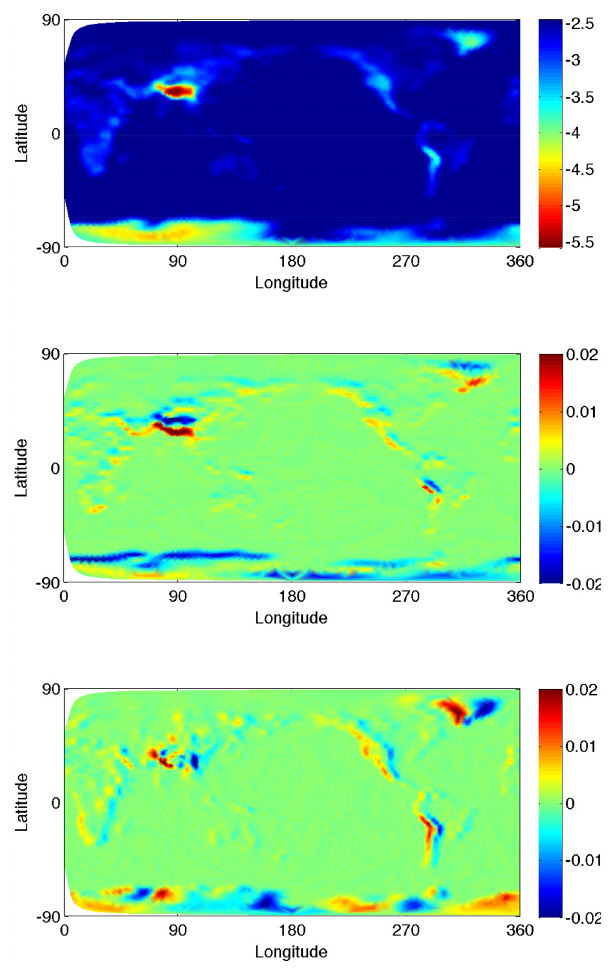
Figure 8. From top to bottom, fair-weather current density (J r , J θ , J λ ) (pAm − 2 ) at 20km above sea level. The green areas in the middle and bottom panels correspond to (J θ , J λ ) < 10 − 4 (pAm − 2 ).